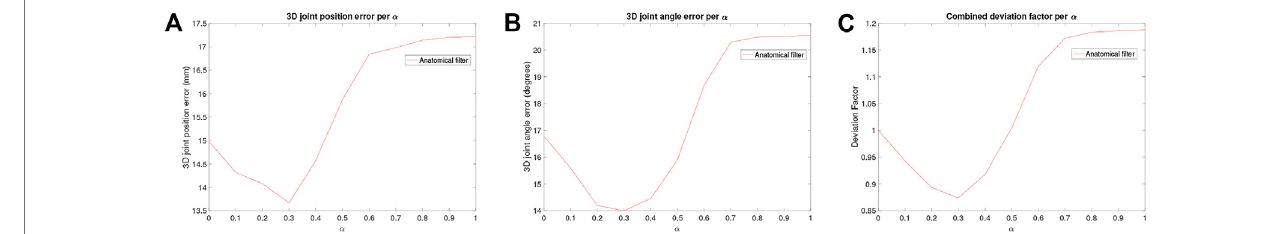
FIGURE6| Graphicalvisualizationoftheresultscomputedforeveryvalueof α usedinthe fi lteronourcustommodel.Thex-axiscorrespondstothevalueof α used forthe fi lter.InPanel6A,they-axiscorrespondstothemean3Djointpositionerrorofthemodel,whichisthemeandistanceofeachjointoftheestimatedposetothejoint ofthe correspondingground truth pose. InPanel 6B,the y-axis correspondstothe3D jointangle errorofthe model, which isthemean error between the27DoF vector oftheestimatedposetothecorrespondingvectorofthegroundtruthpose.Finally,inPanel6C,they-axiscorrespondstothedeviationfactor,whichisthevaluethe error (both joint position and angle errors together) deviates from the point where the fi lter was not used (un fi ltered error).